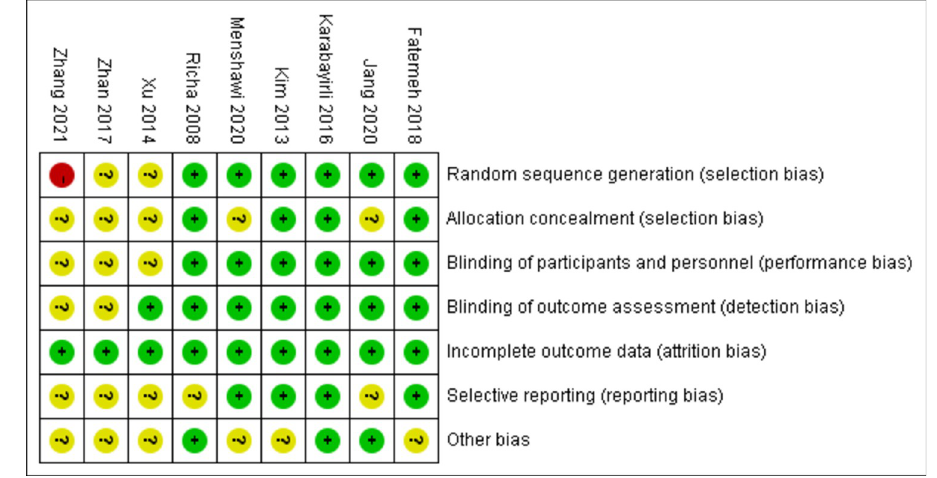
Fig 3. Risk of bias graph in